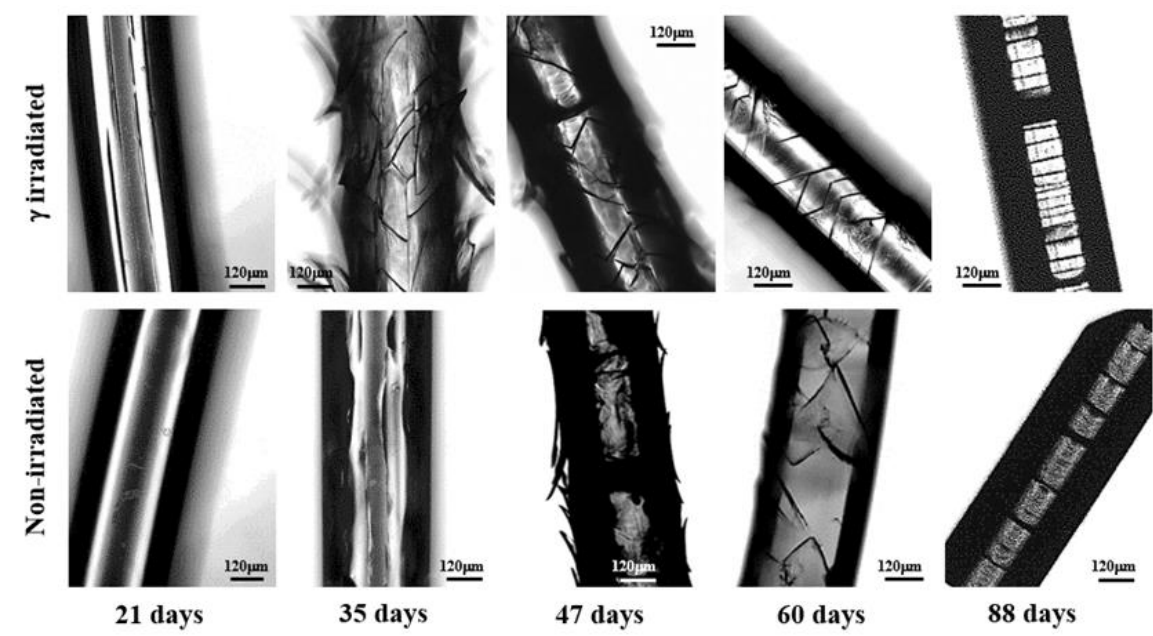
Figure 9. Optical micrographs showing the morphological changes of non-irradiated and γ irradiated GL- b -[GL- co -TMC- co -CL]- b -GL samples during exposure for the indicated times to a pH 7 buffer medium at 37